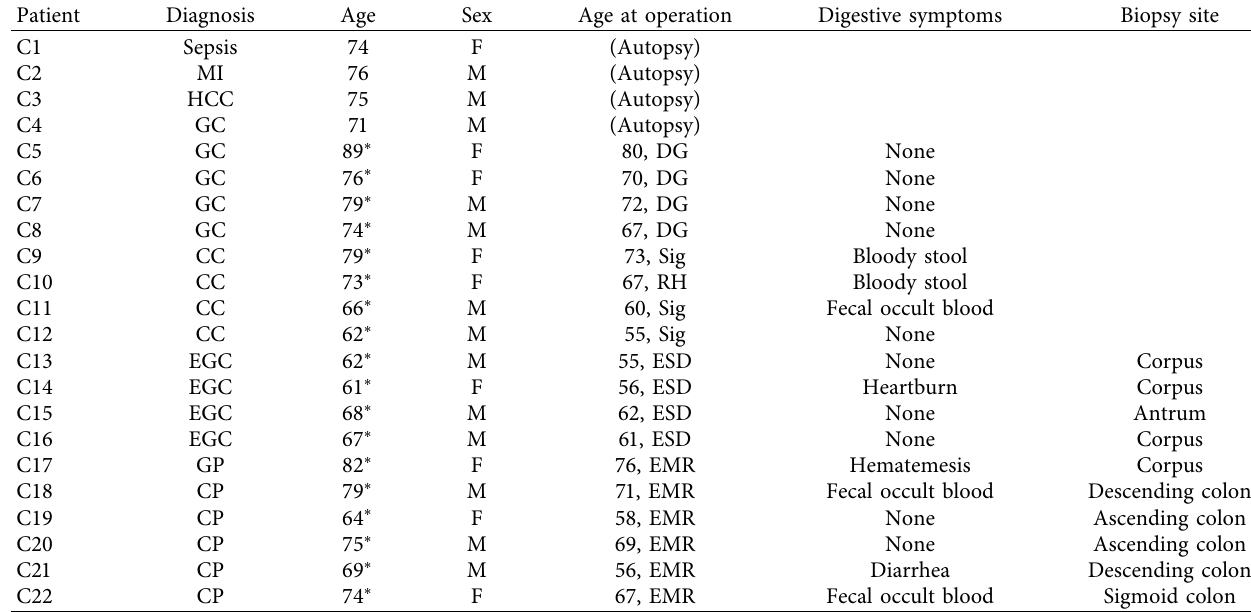
Table 2: Clinical profiles of the control